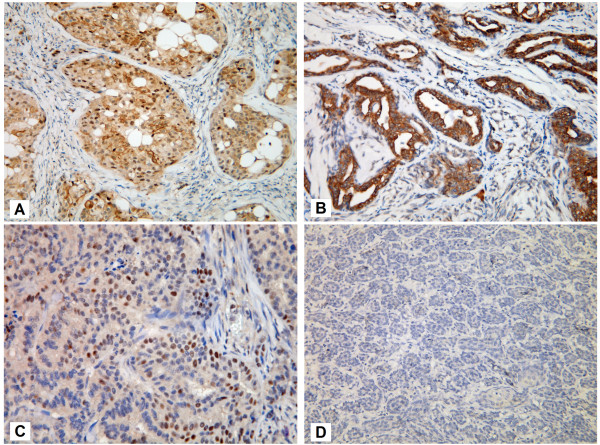
Beclin-1 expression patterns in malignant CMTs. (A) High cytoplasmic and high nuclear expression pattern. (B) High cytoplasmic and low nuclear expression pattern. (C) Low cytoplasmic and high nuclear expression pattern. (D) Low cytoplasmic and low nuclear expression pattern.